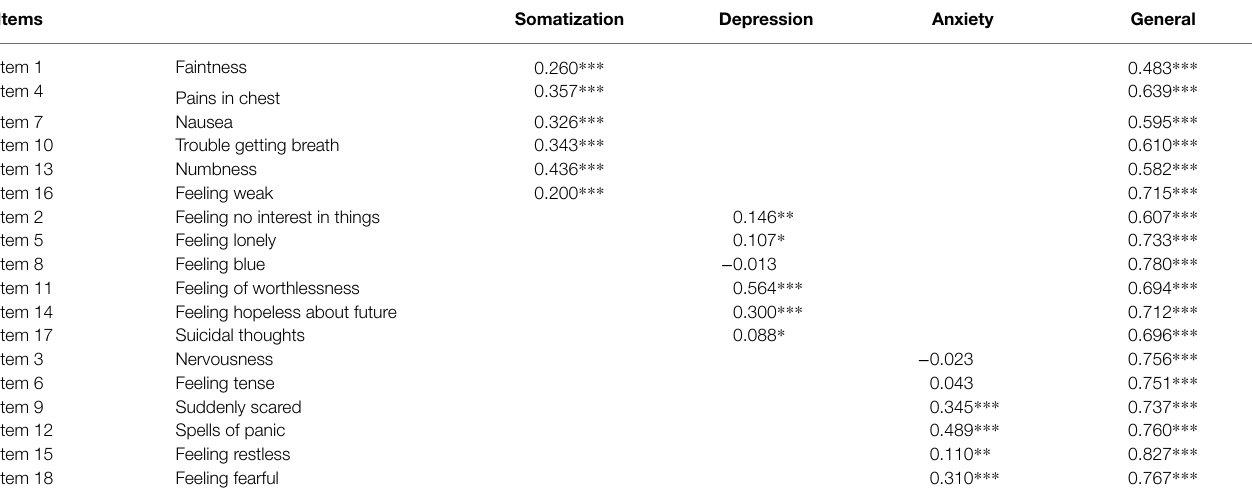
TABLE 4 | Standardized factor loadings for the BSI-18 bi-factor model.